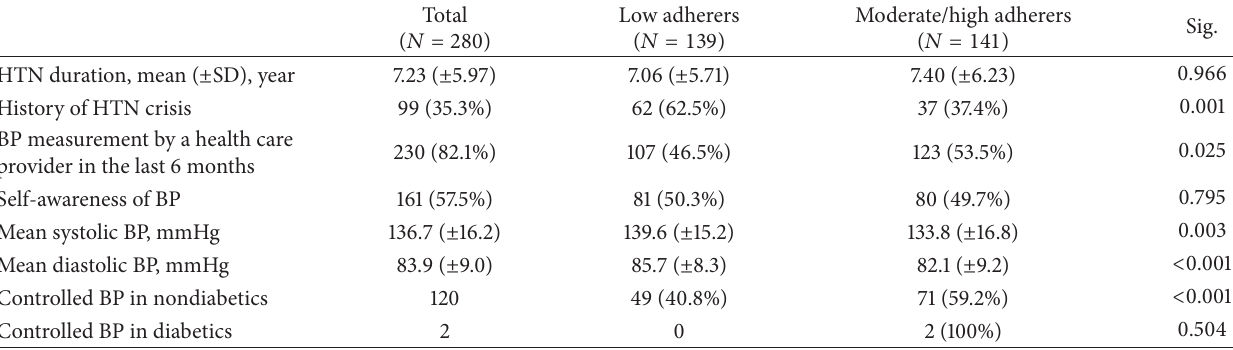
Table2:Comparisonofbloodpressurevariablesbetweenlowandmoderate/highadherencegroupsamong280Iranianhypertensivepatients.